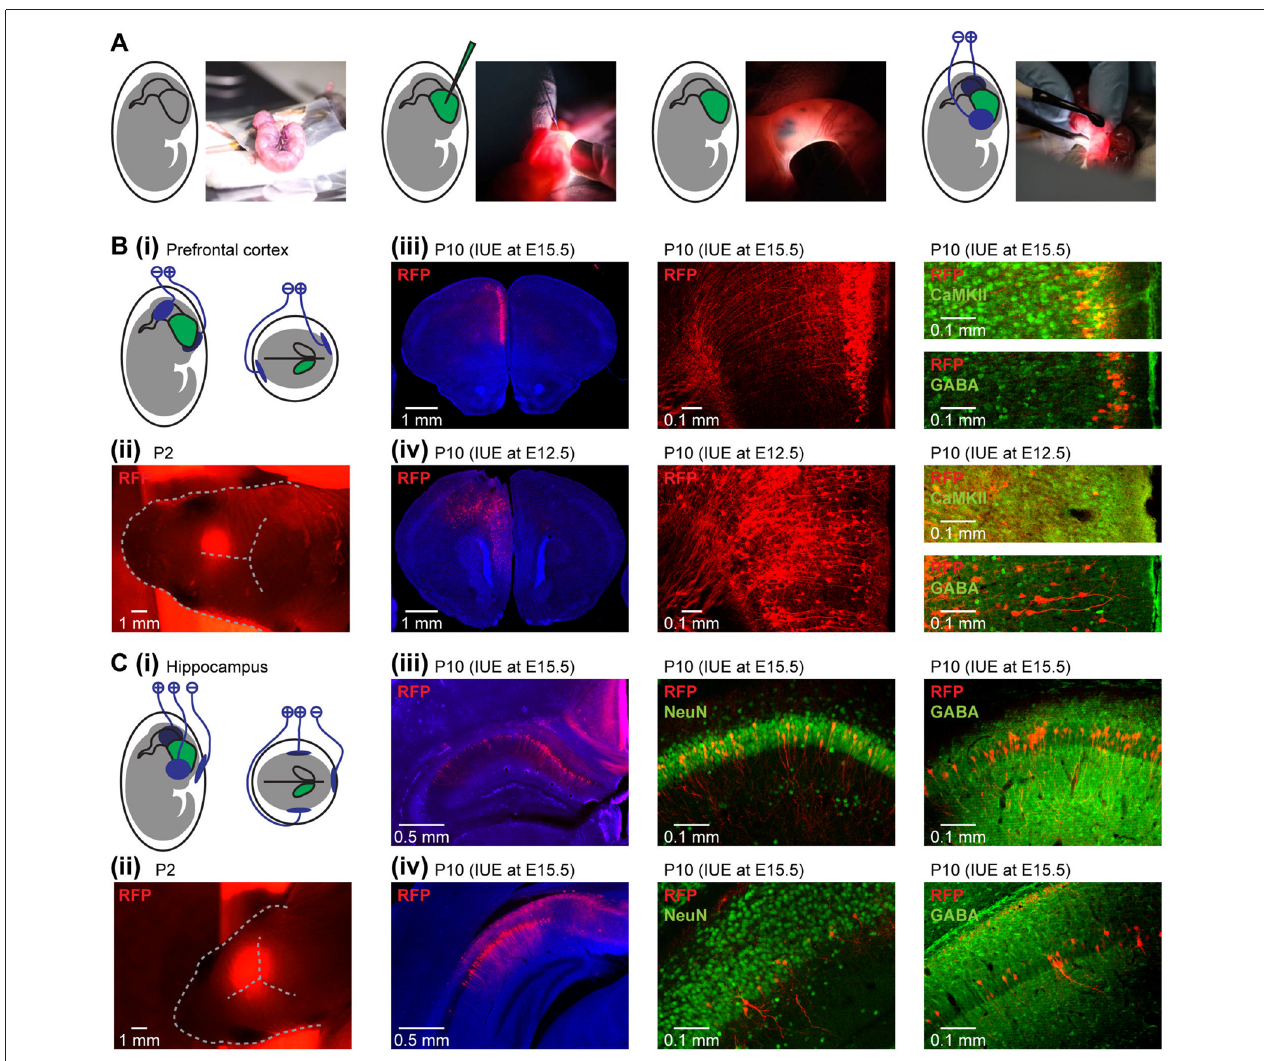
FIGURE 1 | Area-, layer- and cell-type-specificity of neuronal targeting by in utero electroporation (IUE). (A) Diagrams and photographs illustrating the procedure for IUE. (Bi) Schematic representation of the position of electroporation paddles to yield expression in pyramidal neurons in the medial prefrontal cortex (PFC). (ii) Photograph showing the expression of red fluorescent protein (RFP; red) transfected in the PFC by IUE detectable through skull and skin at P2. (iii) Targeting of pyramidal neurons in layer II/III of the neonatal PFC. Left, RFP expressing cells (red) in 50 µ m-thick coronal slices of a P10 mouse at the level of the PFC after IUE at E15.5. Middle, RFP-expressing neurons in prefrontal layer II/III displayed at higher magnification. Right, confocal images of RFP-expressing neurons after staining for Ca2+/calmodulin-dependent protein kinase II (CaMKII) or gamma-aminobutyric acid (GABA). (iv) Targeting of pyramidal neurons in layer V/VI of the neonatal PFC. Same as (iii) for IUE at E12.5. (Ci) Schematic representation of the position of the electroporation paddles to yield expression in pyramidal neurons of hippocampal CA1 area. (ii) Photograph showing the expression of RFP (red) transfected in the hippocampus (HP) by IUE detectable through skull and skin at P2. (iii) Targeting of pyramidal neurons in dorsal hippocampus (HP). Left, RFP expressing cells (red) in 50 µ m-thick coronal slices of a P10 mouse at the level of the dorsal HP after IUE at E15.5. Middle, RFP-expressing neurons in dorsal HP displayed at higher magnification after staining for NeuN. Right, confocal images of RFP-expressing neurons after staining for GABA. (iv) Same as (iii) for the intermediate